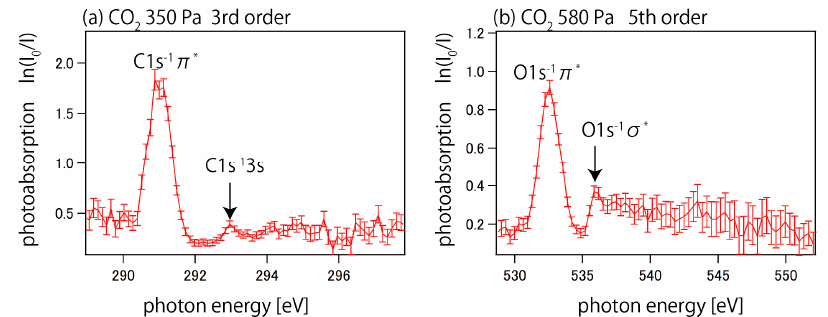
Figure 3. ( a ) Incident (I 0 ) and transmitted (I) 3000-shot average spectra for Ar gas. The photon energy of the incident FEL pulses was 82 eV in the fundamental FEL radiation. ( b ) Absorption spectrum for Ar gas obtained from ln(I 0 / I).